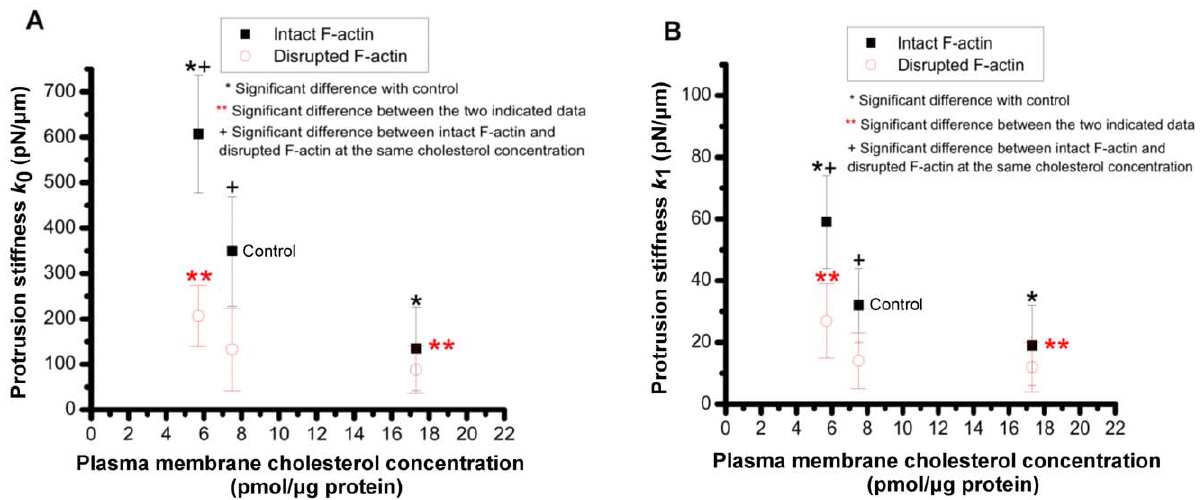
Figure 7. Protrusion stiffness. Effect of membrane cholesterol content on: ( A ) stiffness parameter k 0 , and ( B ) stiffness parameter k 1 for cells with intact or disrupted F-actin.